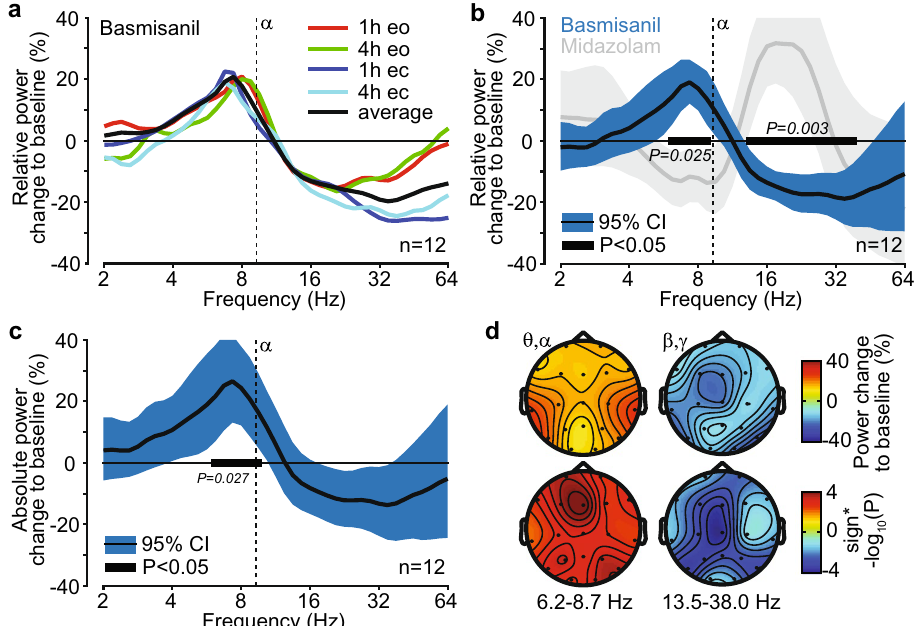
Figure 6. Electrophysiological signature of basmisanil in healthy volunteers. ( a ) Relative power change of EEG signals averaged across electrodes in response to basmisanil, separately for eyes open and eyes closed conditions at 1 and 4 h post morning dose after 14 days of 240 mg basmisanil treatment twice daily. ( b ) Relative power change of EEG signals averaged across electrodes in response to basmisanil (average of eyes open and eyes closed conditions, 1 h and 4 h post morning dose after 14 days of 240 mg basmisanil treatment twice daily) and in response to midazolam (grey: eyes open and eyes closed, 1 h post single dose of 2 mg). Black bars indicate significant effects for basmisanil (cluster randomization test). ( c ) Absolute power change of EEG signals averaged across all electrodes in response to basmisanil (average of eyes open and eyes closed conditions, 1 and 4 h post morning dose after 14 days of 240 mg basmisanil treatment twice daily). Black bar indicates significant effect (cluster randomization test). ( d ) Spatial distribution of power changes and p-values (derived from t-tests) for the two significant clusters identified for basmisanil (black bars in ( b )). Top panel: power changes; bottom panel: p-values; left: low-frequency cluster (6.2–8.7 Hz); right: high-frequency cluster (13.5–38.0 Hz). CI confidence interval (uncorrected for multiple testing across frequencies). See Supplementary Fig. S5 for additional EEG analyses and Fig. 5 for basmisanil exposure and receptor occupancy ranges during EEG